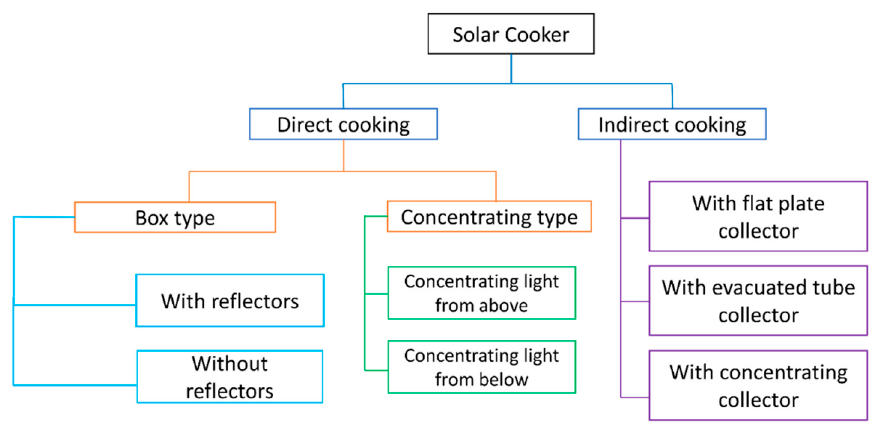
Figure 1. Classification of solar cooker. The temperature attained in the box type is medium (approx. 120 °C) [17] and very high in concentrating type (approx. 290 °C); however, indirect cooker has a high temperature but with a control option. Reprinted/adapted with permission from Ref. [18], 2018, Elsevier.